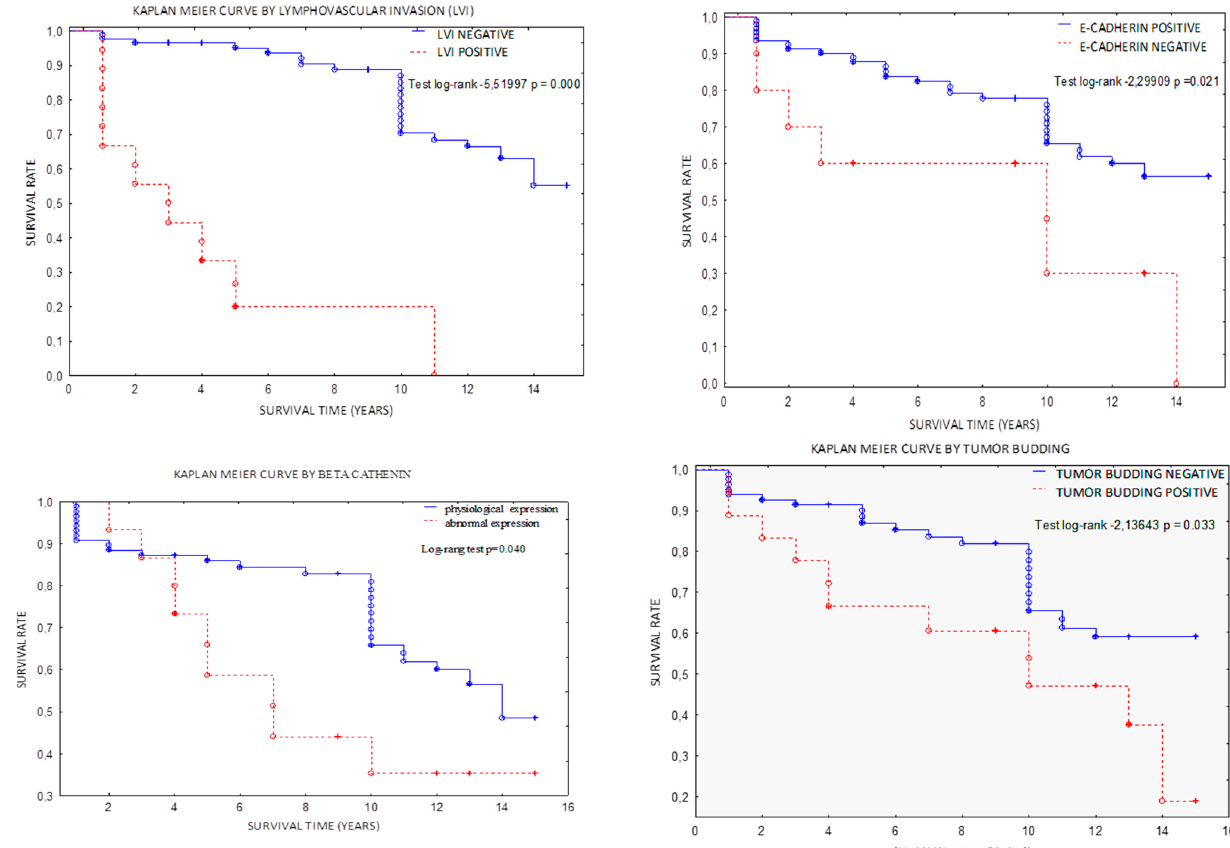
Figure 1. Kaplan–Meier curves for lymphovascular invasion, loss of E-cadherin, β -catenin, and tumor budding. Table 4. A comparison of univariate and multivariate Cox models.